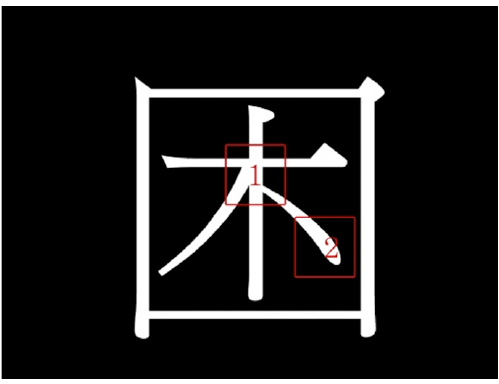
Figure 5. ANOVA of module type and recurrence